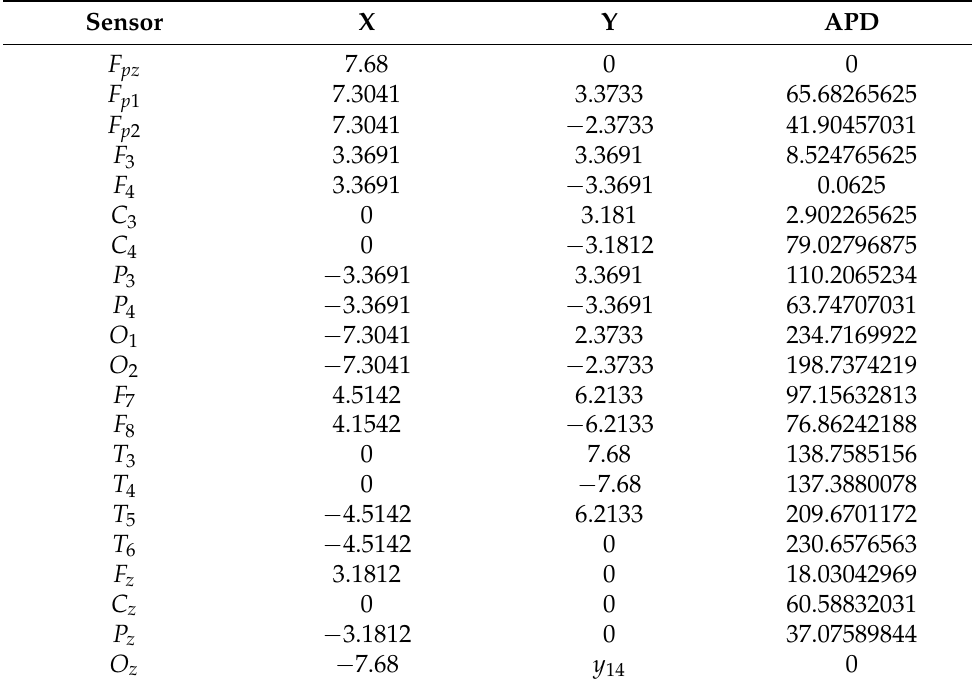
Table 4. APD at the sensor on an MC at t = 3 of patient A